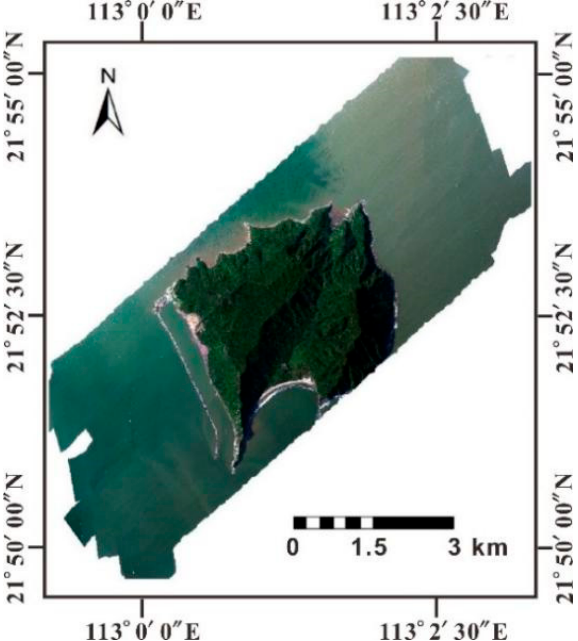
Figure 2. True color synthesis of the CASI data from the study area. Preprocessing of the CASI image mainly included radiometric correction, geometric correction, image mosaic, atmospheric correction, and water body extraction. The geomet- ric correction was based on the Global Positioning System (GPS)/Inertial Measurement Unit (IMU)-assisted aerial linear array push broom imaging technology. The system